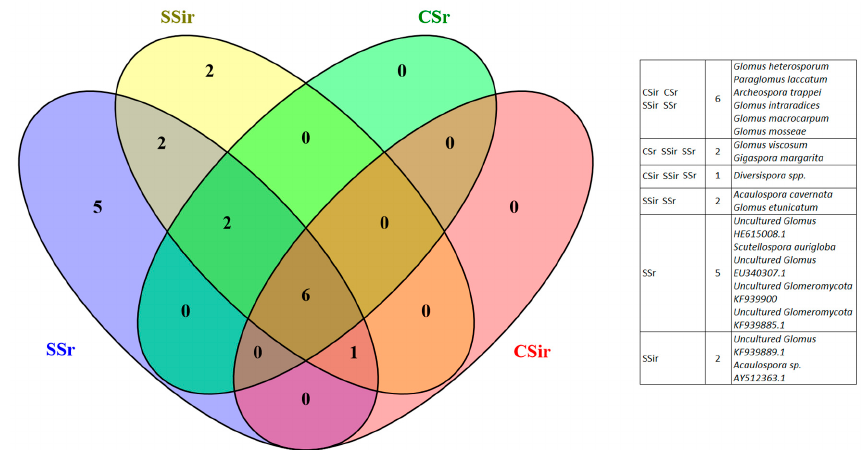
Figure 5. Venn diagram reporting the distribution of the identified operative taxonomic units (OTUs), each represented by the most abundant morphotype. each represented by the most abundant